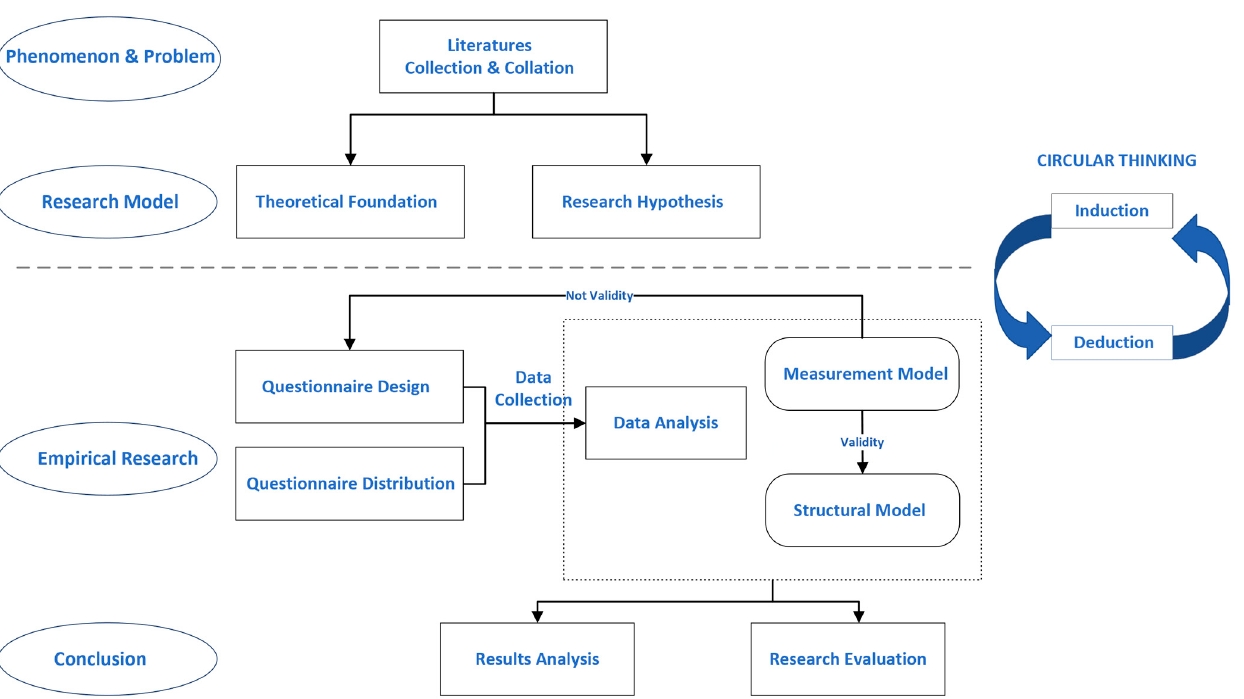
Figure 2. Research procedure.